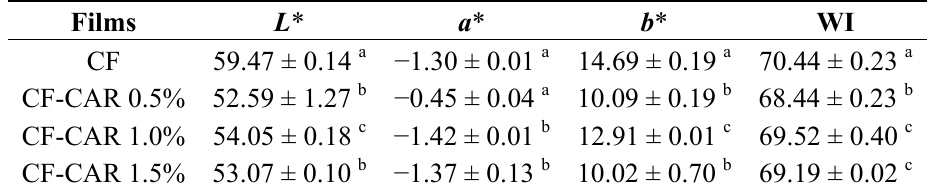
Table 2. Color and WI parameters of CF and CF-CAR